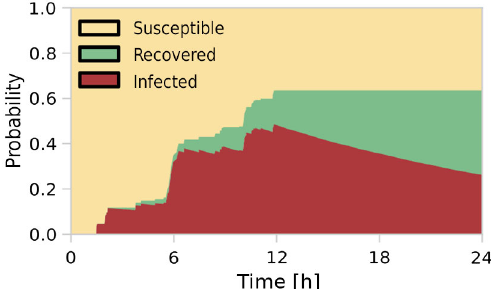
FIG. 1. Illustrative examples of a simulated epidemic outbreak from a single initially infected node. Colors give the probability that another arbitrarily selected node is in the susceptible (yellow), infected (red), or recovered (green) state, respectively.